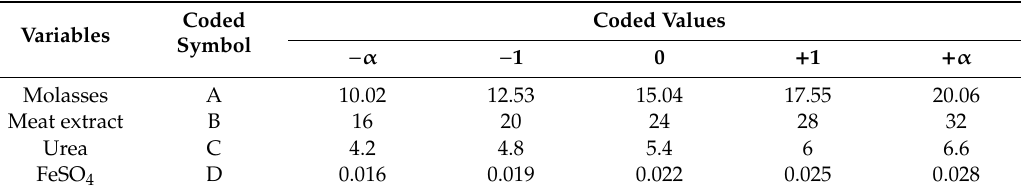
Table 13. Coded and real values of variables selected for CCD of tryptophan production by P. acidilactici TP-6.